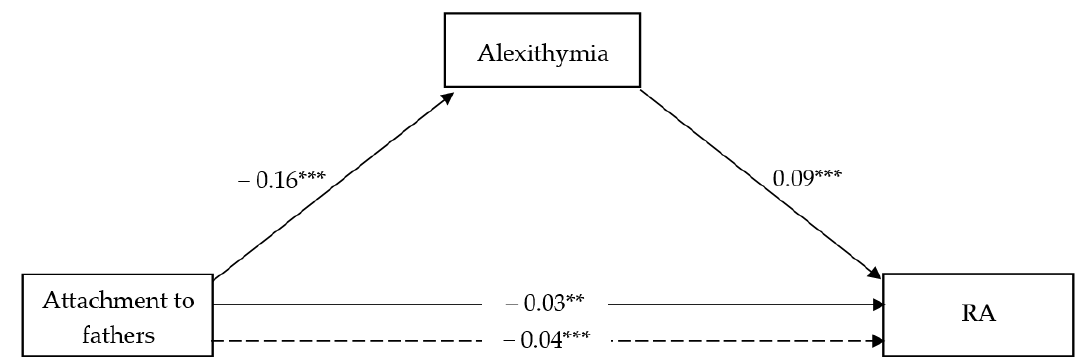
Figure 3. Attachment to father and RA. ** p < 0.01; *** p < 0.000; dotted line = Total effect.